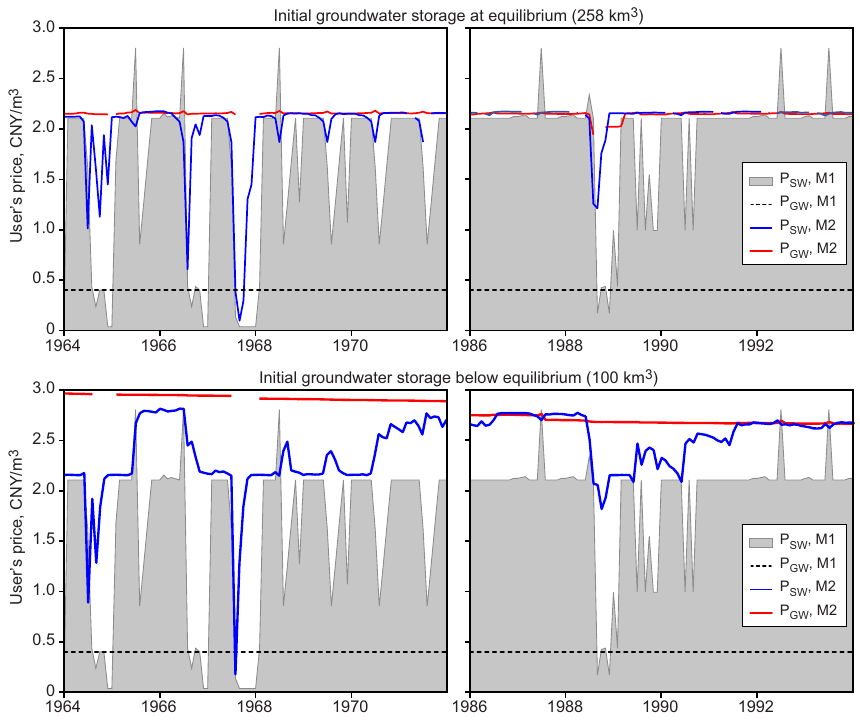
Figure 7. User’s price for groundwater and surface water through for a 51-year simulation based on simulated historical runoff for two initial groundwater storages. P refers to the user’s price. M1 denotes results for a single surface water reservoir with a constant groundwater cost (Davidsen et al., 2015). M2 denotes results from the presented model framework with an additional dynamic groundwater aquifer. The user’s price for groundwater in M2 is the immediate pumping cost added to the marginal cost from the water value